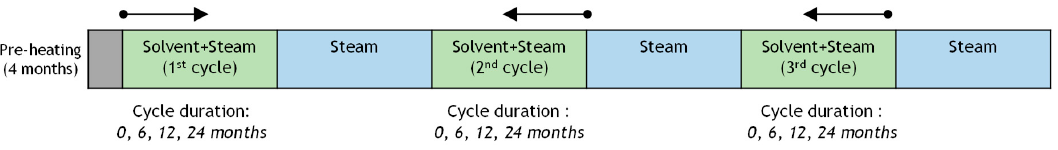
Figure 12. Combinations of cycle durations for a group of simulations of cyclic ES-SAGD using hexane at 10% mole and three cycles of solvent-steam injection.